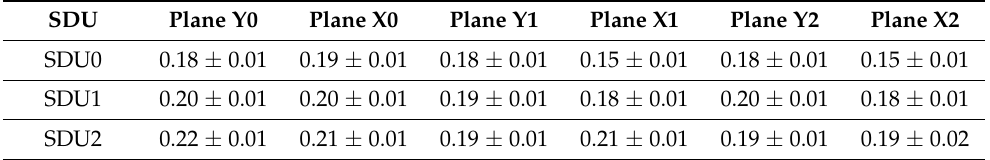
Figure 6. Simulated particles’ LET/plane (in keV/ µ m) vs. experimental data (in ADC) for all the silicon planes of the three SDUs. Linear fits are displayed to demonstrate the variability between different planes. A low-LET blow-up is shown to demonstrate the sensitivity of the detector below the threshold value of 3 keV/ µ m (red dashed line). Note that measurements for C200 and C180 in the different silicon planes partially overlap. Table 1. Conversion factors (keV/ µ m vs. ADC channels) for the SDU0, SDU1 and SDU2 silicon planes. Differences among different planes are within